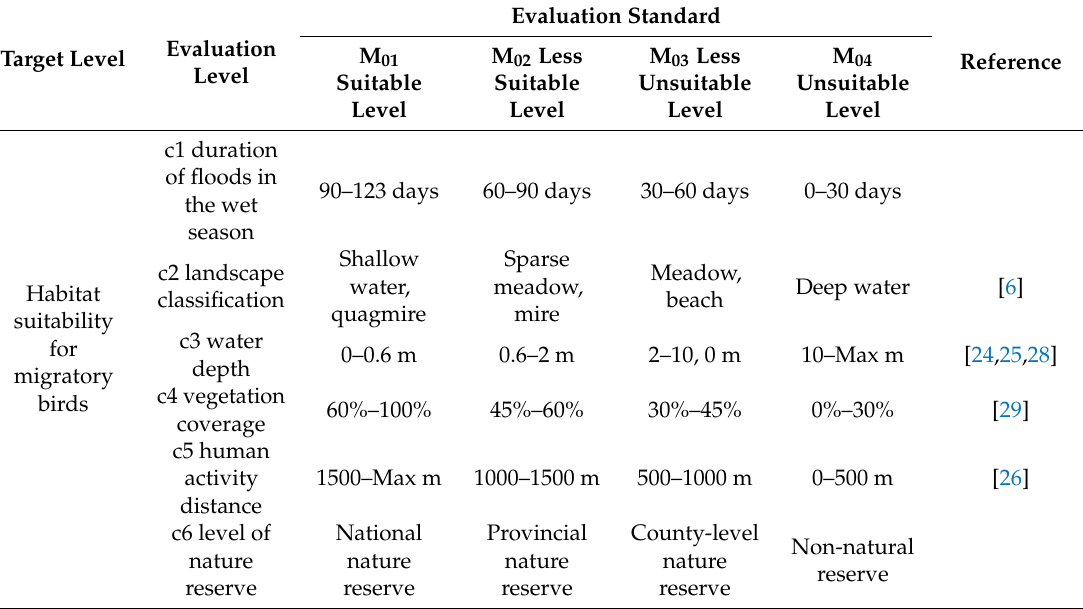
Table 1. Classification of the evaluation factors for habitat suitability for migratory